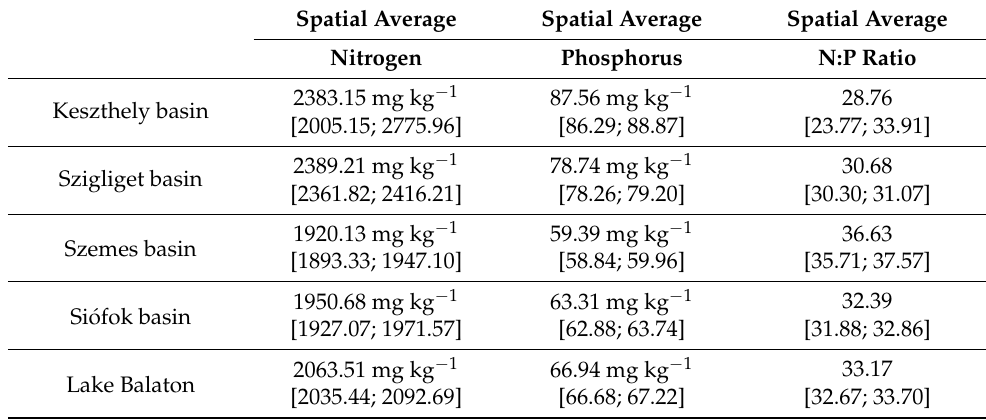
Figure 7. Accuracy plots (open circles) and computed G statistics for the nutrients nitrogen ( left graph ) and phosphorus ( middle graph ) and for nitrogen-to-phosphorus ratio ( right graph ). Abbre- viation: G: G statistics. Table 4. Spatial averages for the basins and for the entire lake as results of spatial aggregation. Annotation: numbers in square brackets present the upper and lower limit of the 90% prediction interval as a measure of spatial uncertainty. Abbreviation: N:P ratio: nitrogen-to-phosphorus